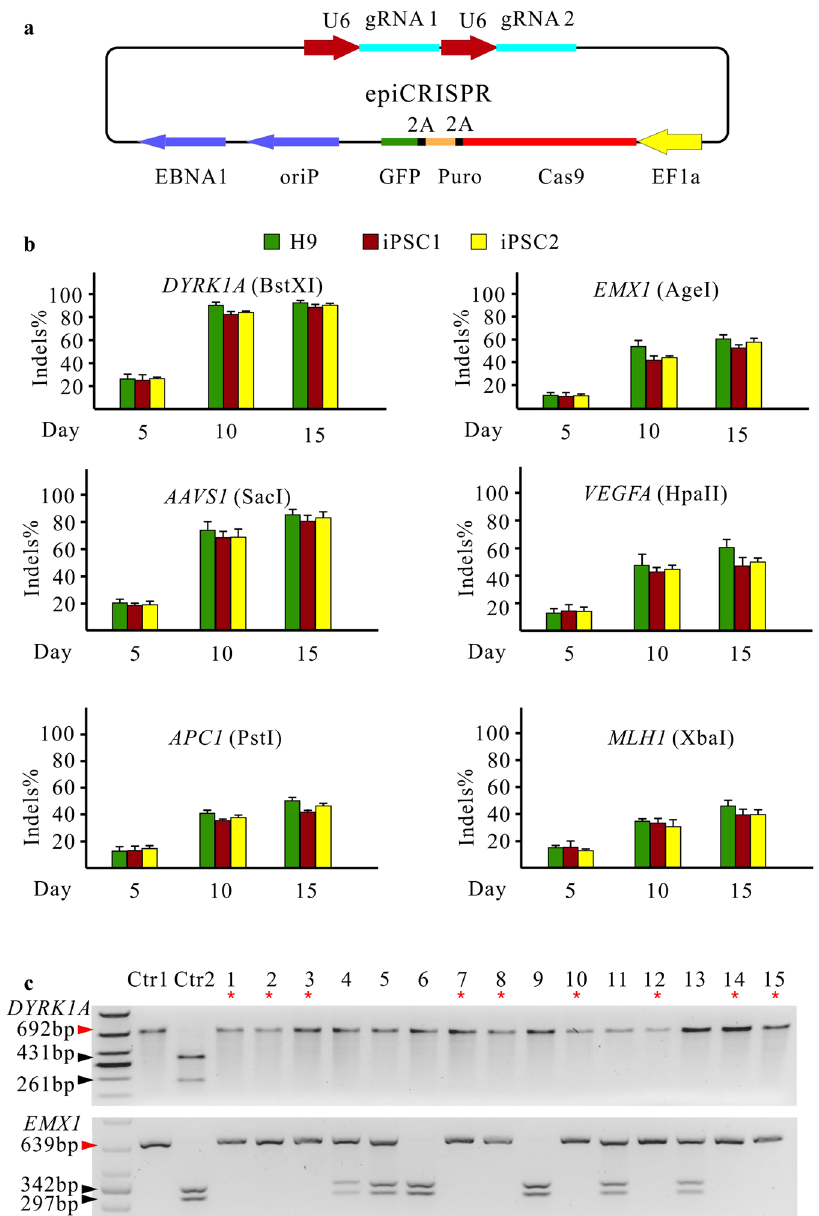
Figure 3. The epiCRISPR system for efficient double-gene knockout. ( a ) Expression of two gRNAs on the epiCRISPR vector for double-gene knockout. ( b ) RFLP analysis of the indel rates generated by the epiCRISPR system with gRNA multiplexed targeting DYRK1A & EMX1 , AAVS1 & VEGFA and APC1 & MLH1 in hPSCs (n = 3, error bars show mean ± S.D.). ( c ) RFLP analysis of single cell-derived clones multiplexed targeting DYRK1A and EMX1 loci. Ctr1 is the PCR band from unmodified cells without digestion. Ctr2 is the PCR band from unmodified cells with digestion (BstXI for DYRK1A and AgeI for EMX1 ). Red triangles indicate the epiCRISPR-modified PCR bands; black triangles indicate unmodified PCR bands; the red asterisks indicate the homozygous knockout for both